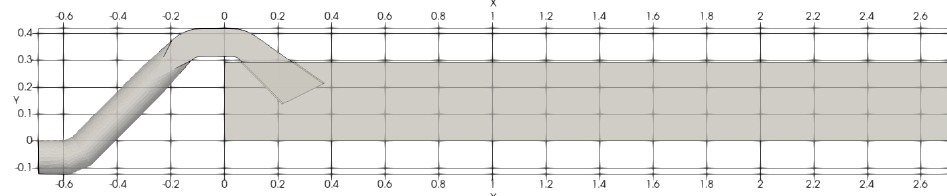
Figure 2. Side view of the computational domain.